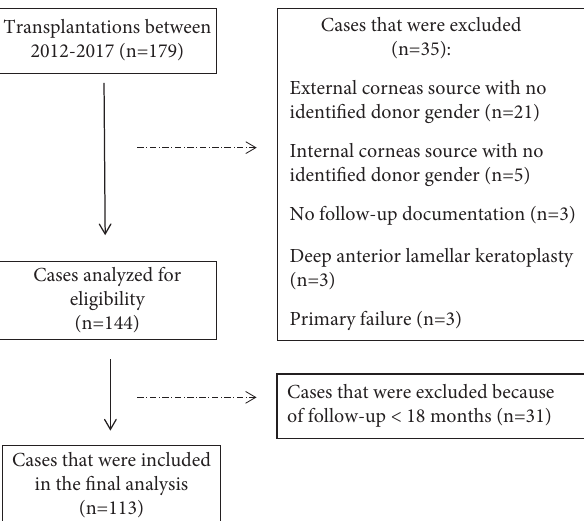
Figure 1: Flow diagram of the patients included in the